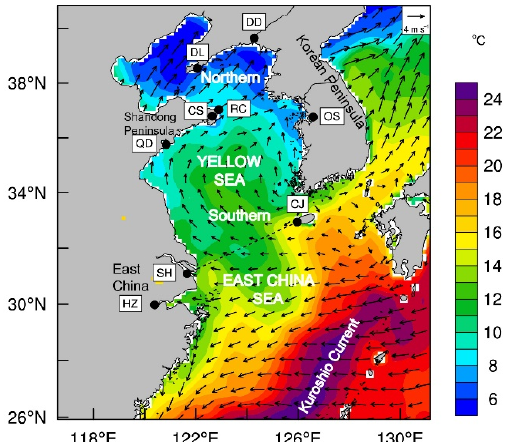
Figure 1. Geographic map of the Yellow Sea (includes the northern and southern parts) overlayed with sea surface temperature (shaded; °C) and 10 m wind field (vectors; m s − 1 ) at 1200 UTC 9 May 2009 from ECMWF Reanalysis v5 (ERA5) data. Locations of sounding stations (Shanghai, Hangzhou, Chejudo, Qingdao, Chengshantou, Rongcheng, Dalian, Dandong, and Oscan are referred to SH, HZ, CJ, QD, CS, RC, DL, DD, and OS for short) are marked using black dots.